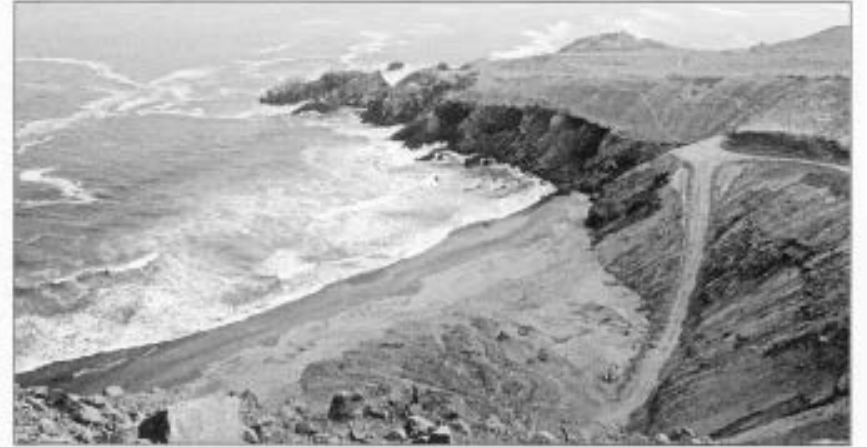
Figure 2 View northwest of the coast at Wawakiki, just south of Ilo. There is a multi­ period settlement site on the promontory.